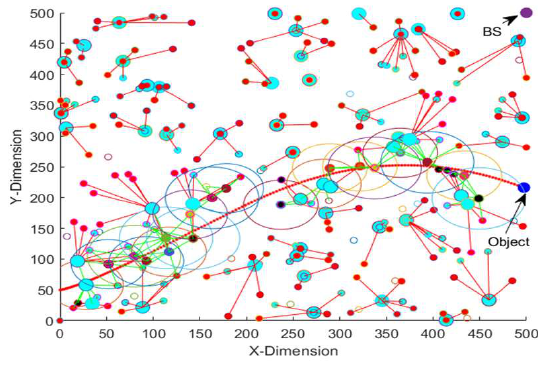
Figure 8. Object in trajectory 3. Table 13. Energy consumption, average detection error and average object localization error. Trajectory No.